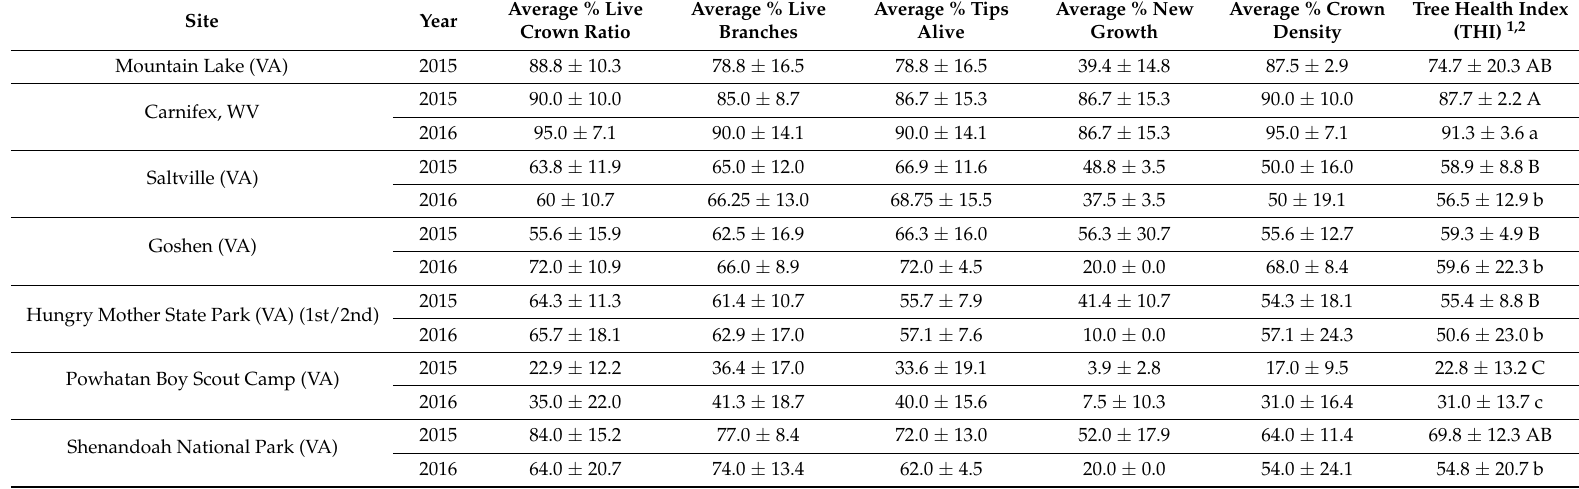
Table 1. The local Laricobius osakensis release sites in Virginia and West Virginia, post-release sampling year, and average health index measures ( ± SD) of hemlock